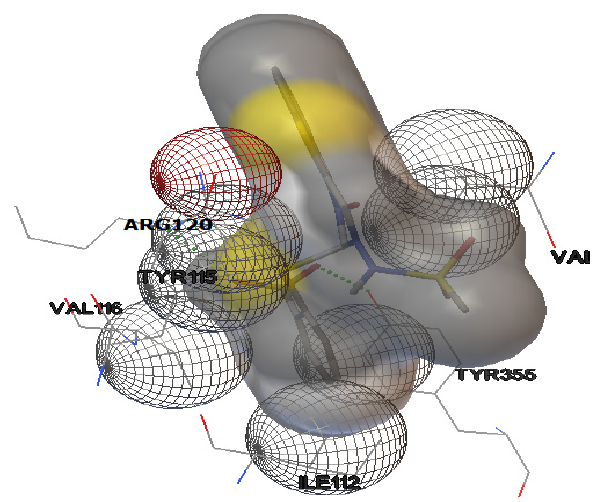
Figure 7. Binding of 10 into the active site of